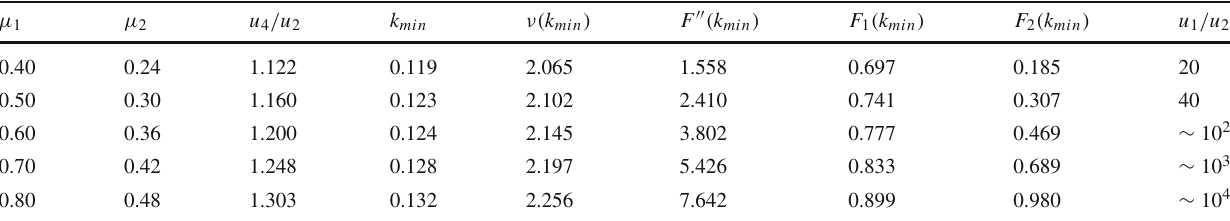
Table 1 A few examples of critical parameter values approximately satisfying (32), i.e., cancelling the linear c 1 terms in (27) at least up to O ( 10 − 2 ) compared to the non-negative c 2 terms, allowing simultaneous stabilization of both moduli around k min ∼ 0 . 1 and c min ∼ 1